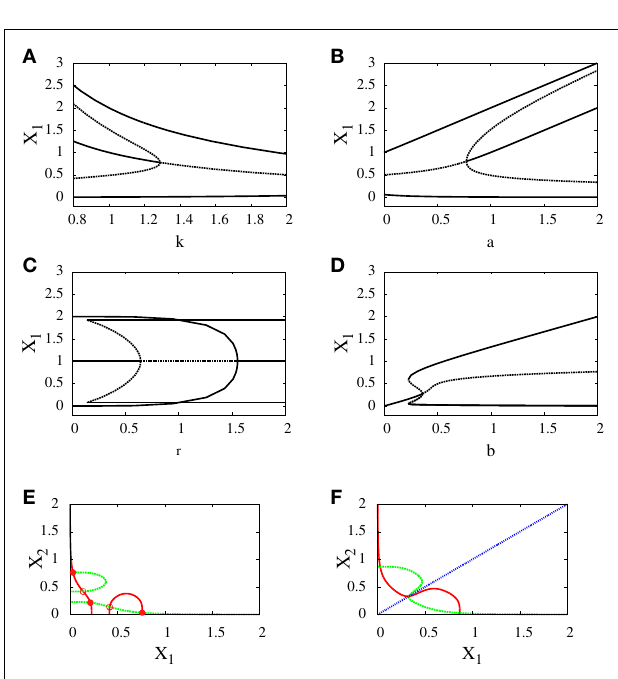
FIGURE 5 | Subcritical pitchfork bifurcation diagrams for symmetric scenario . Bifurcation diagrams (A–D) and nullclines at the beginning (E) and end (F) of the bifurcation diagram (D) . For all n = 4. For (A) a = 1, b = 1, r = 0.5, (B) b = 1, k = 1, r = 0.5, (C) a = 1, b = 1, k = 1, (D–F) a 1 = a 2 = 1, k 1 = k 2 = 1.5. In (C) there is also supercritical pitchfork